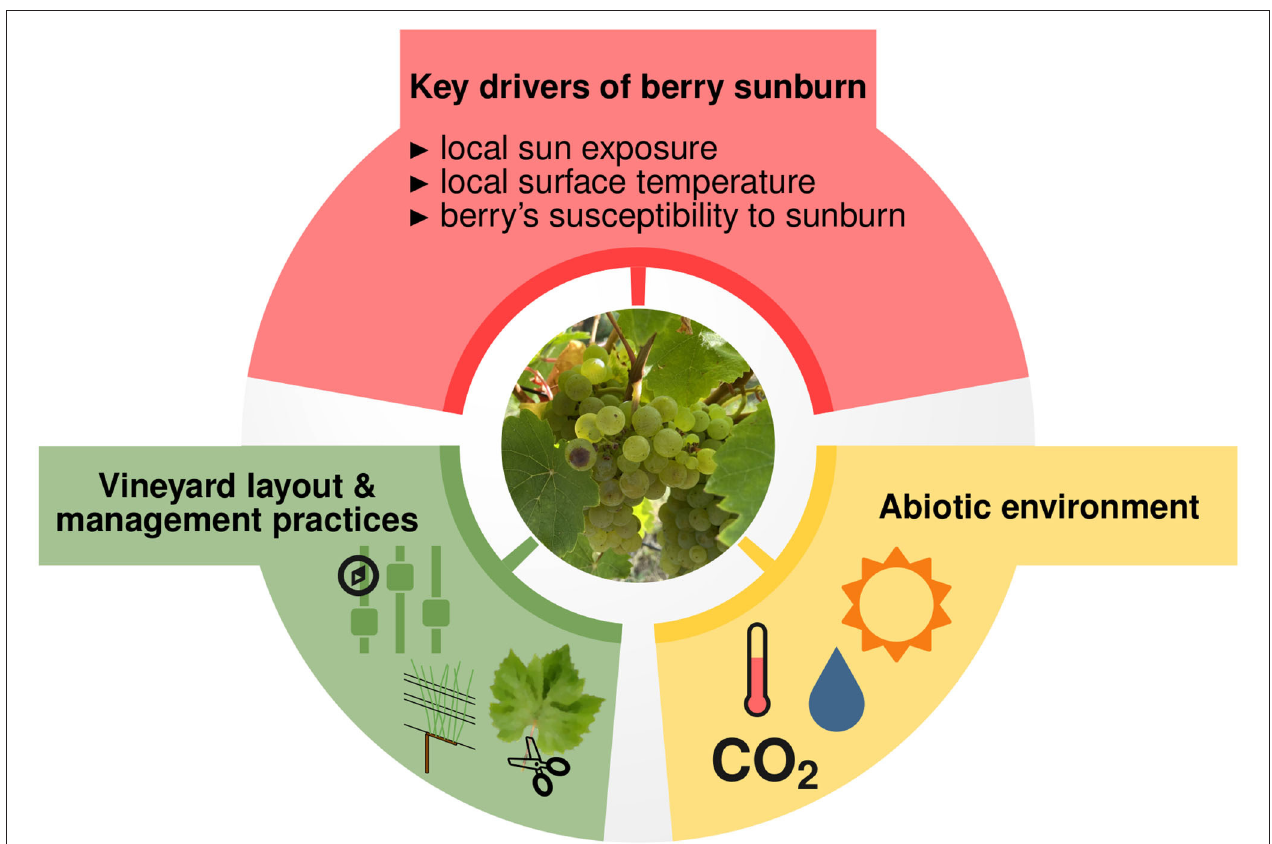
FIGURE 1 | Sunburn in grapevine berries is a heat-induced disorder that requires direct exposure of the berries to the sun. Gambetta et al. (2021) suggested to predict the occurrence of berry sunburn from local sun exposure, local surface temperature, and the susceptibility of berry to sunburn. These traits are affected by environment and plant management. The abiotic environment can influence both heat impact on berries and vine architecture, thus local sun exposure. Plant architecture is also determined by the vineyard layout and management practices, such as shoot positioning and leaf removal, which in turn influences light penetration into the canopy and thereby affects sunburn